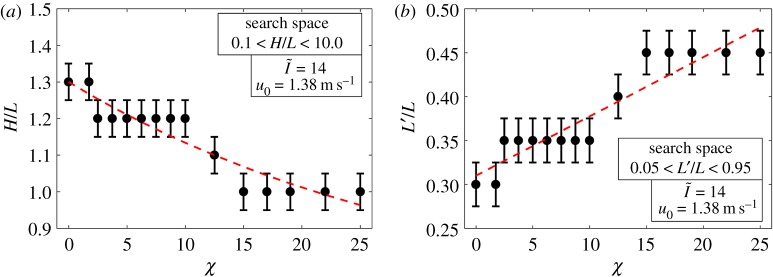
Effect of solar zenith angle on (a) the optimal mound height, represented by H/L, and (b) spire width, represented by L′/L. The red line and the error bar, respectively, represent the overall trend and the numerical uncertainty of the results within the resolution of the optimization method.